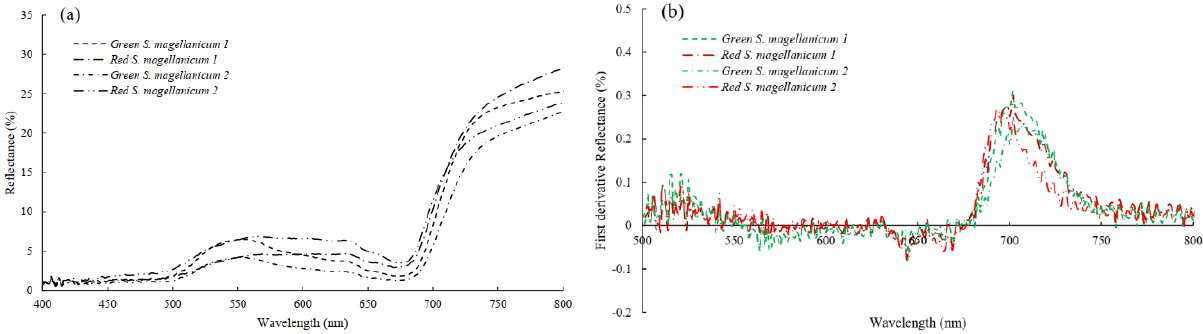
Figure 9. Response of spectra (VIS; 400–760 nm) to pigment changes in Sphagnum leaves: (a) the original spectra of the individual scenes of green and red S. magellanicum examined in Plot 1, and (b) the corresponding FDR